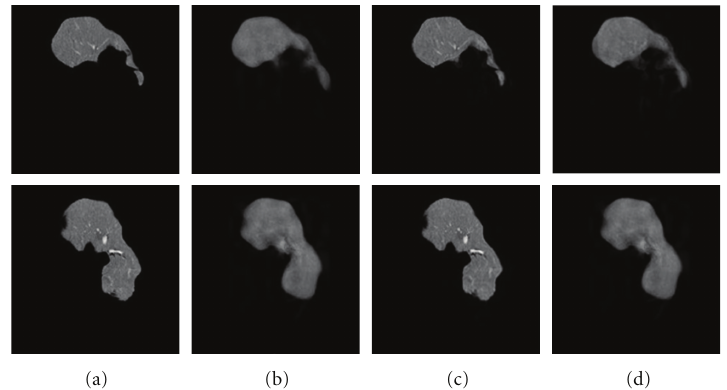
Figure 7: Reconstructed results for two slices of one test sample after shape normalization. (a) 3D shape-normalized images. (b) Images reconstructed with 10 × 10 × 4 basis by GND-PCA. (c) Images reconstructed with 100 × 100 × 40 basis by GND-PCA. (d) Images reconstructed by PCA (eigenface method); all 15 available bases are used in the reconstruction.